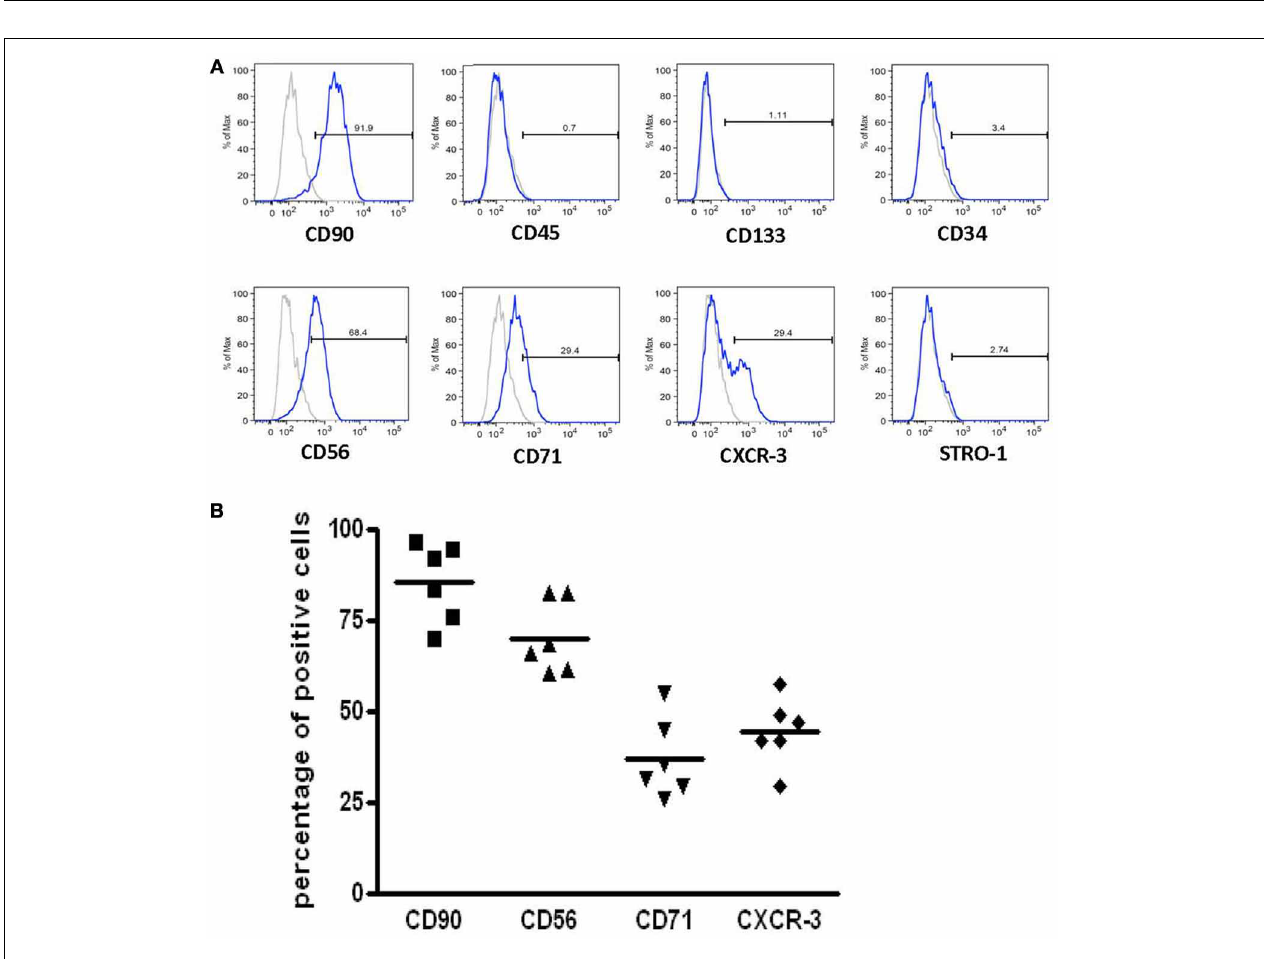
representative patient (B) The mean of the percentages of CD56, CD71, CD90, and CXCR3 positive cells from 6 patients using